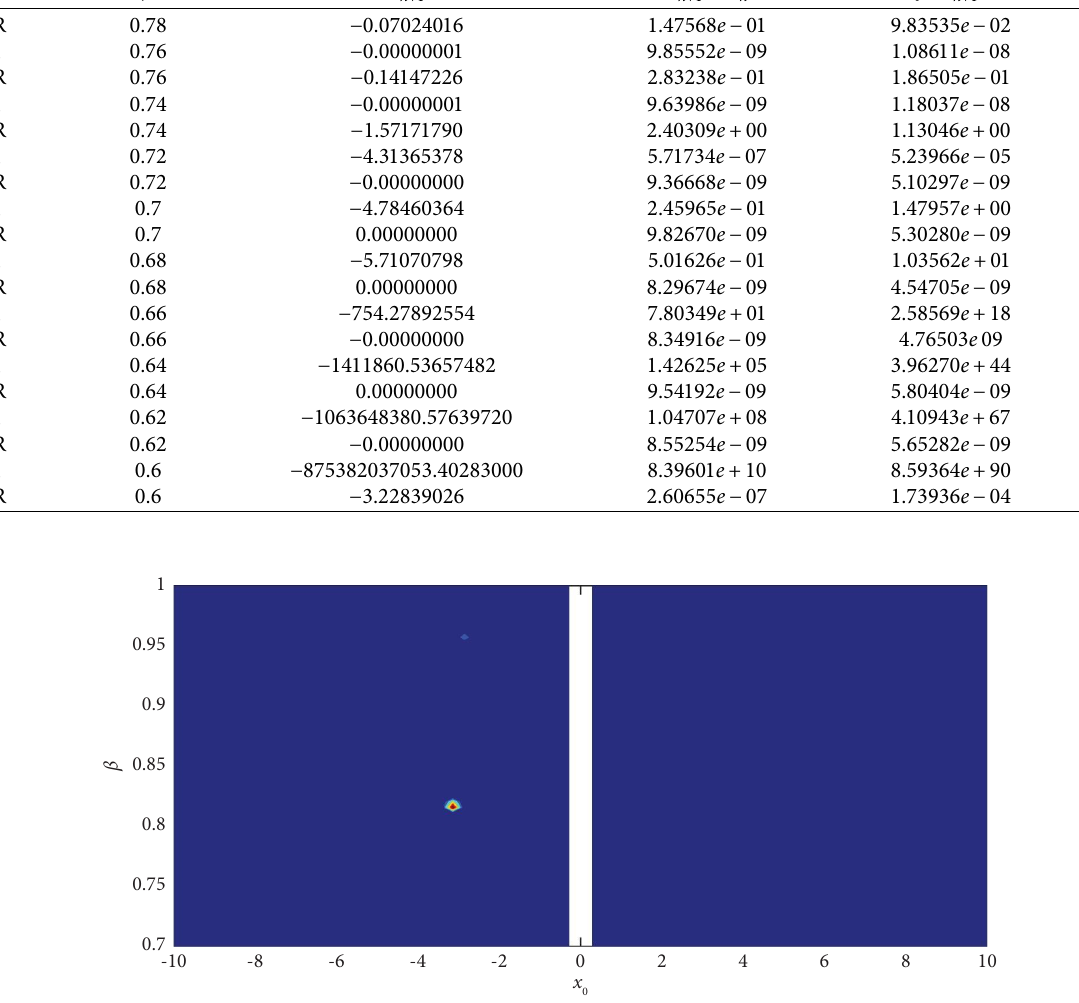
( x ) for Caputo derivative. 2